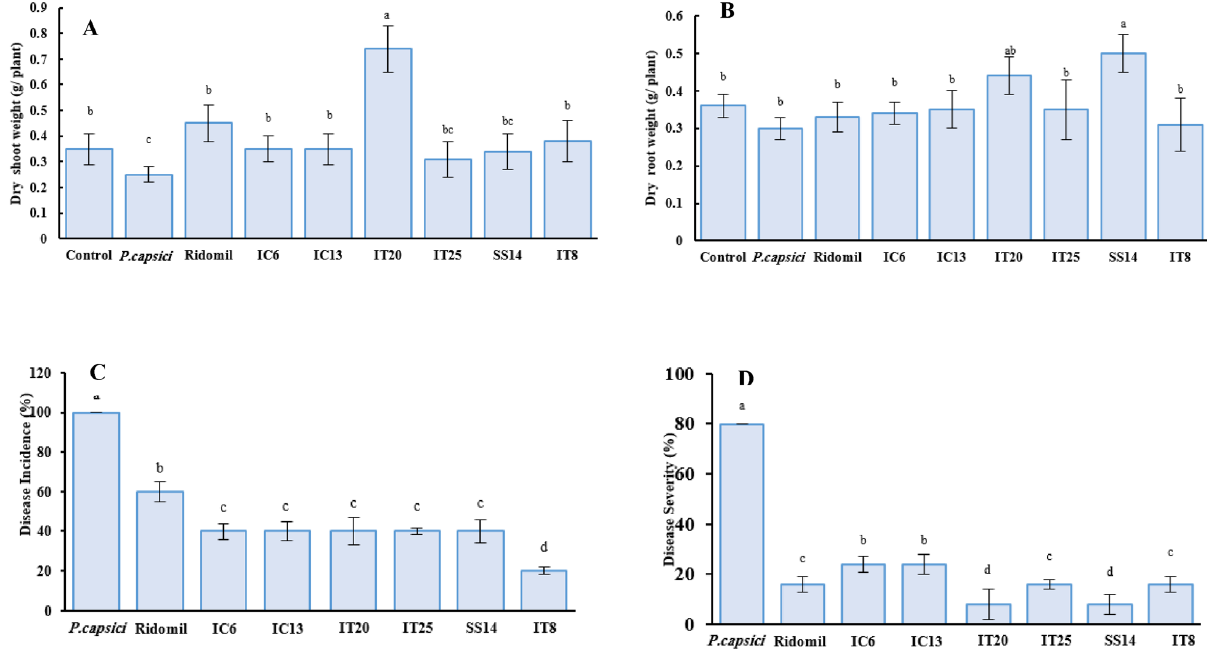
Figure 1. Biocontrol effect of selected antagonistic isolates against pepper blight caused by Phytophthora capsici through dry shoot and ( A ) root weight ( B ) disease incidence ( C ) and disease severity ( D ) in greenhouse conditions. Data recorded 15 days after inoculation in seedling stage. Same letters represent non-significant difference according to Duncan’s Multiple Range Test ( P < 0.05 ). Melanin production Growth (in/on)